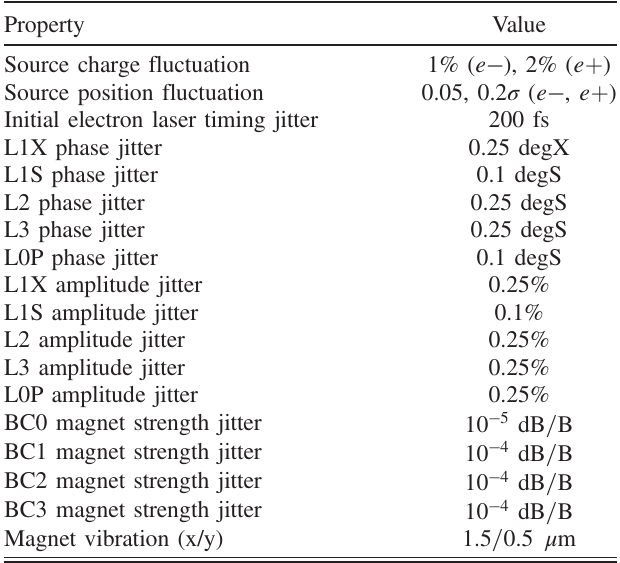
TABLE IX. rms jitter parameters used in the Monte Carlo tracking simulation.